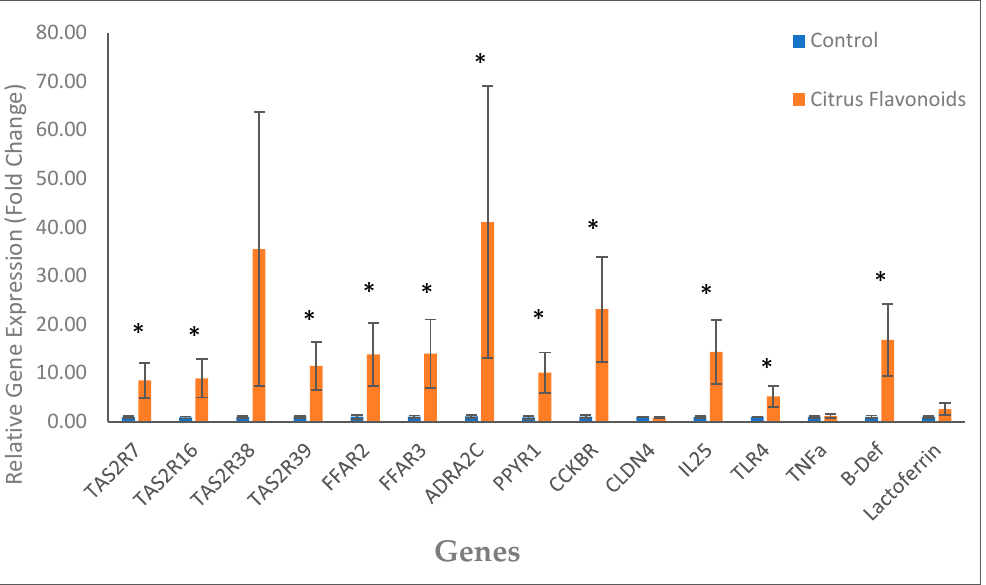
Figure 1. Gene expression in rumen epithelium of Holstein bulls fed high-concentrate diets with or without citrus flavonoids supplementation (* = p < 0.05). TAS2R7: bitter taste receptor 7 ; TAS2R16: bitter taste receptor 16 ; TAS2R38: bitter taste receptor 38 ; TAS2R39: bitter taste receptor 39 ; FFAR2: free fatty acid receptor 3 (gpr41) ; FFAR3: free fatty acid receptor 2 (gpr43) ; ADRA2C: alpha 2 adrenergic receptors subtype C ; PPYR1: pancreatic polypeptide receptor 1 ; CCKBR: cholecystokinin receptor 4 ; IL-25: interleukin-25 ; TLR4: pattern recognition receptors, such as Toll-like receptor 4 ; TNFa: tumor necrosis factor alpha ; B-Def: beta-defensin . Data of the relative expression of duodenum epithelium genes are presented in Figure 2. Again, the supplementation with flavonoids affected the expression of all bitter taste receptors (TAS2R) analyzed except TAS2R38. Contrary to the results in the rumen epithelium, in the duodenum, the relative expression of TAS2R7, TAS2R16, and TAS2R39 was greater ( p < 0.001) in the C bulls compared with the BF bulls. The relative expression of some receptors related with the neurotransmitter signaling also differed among